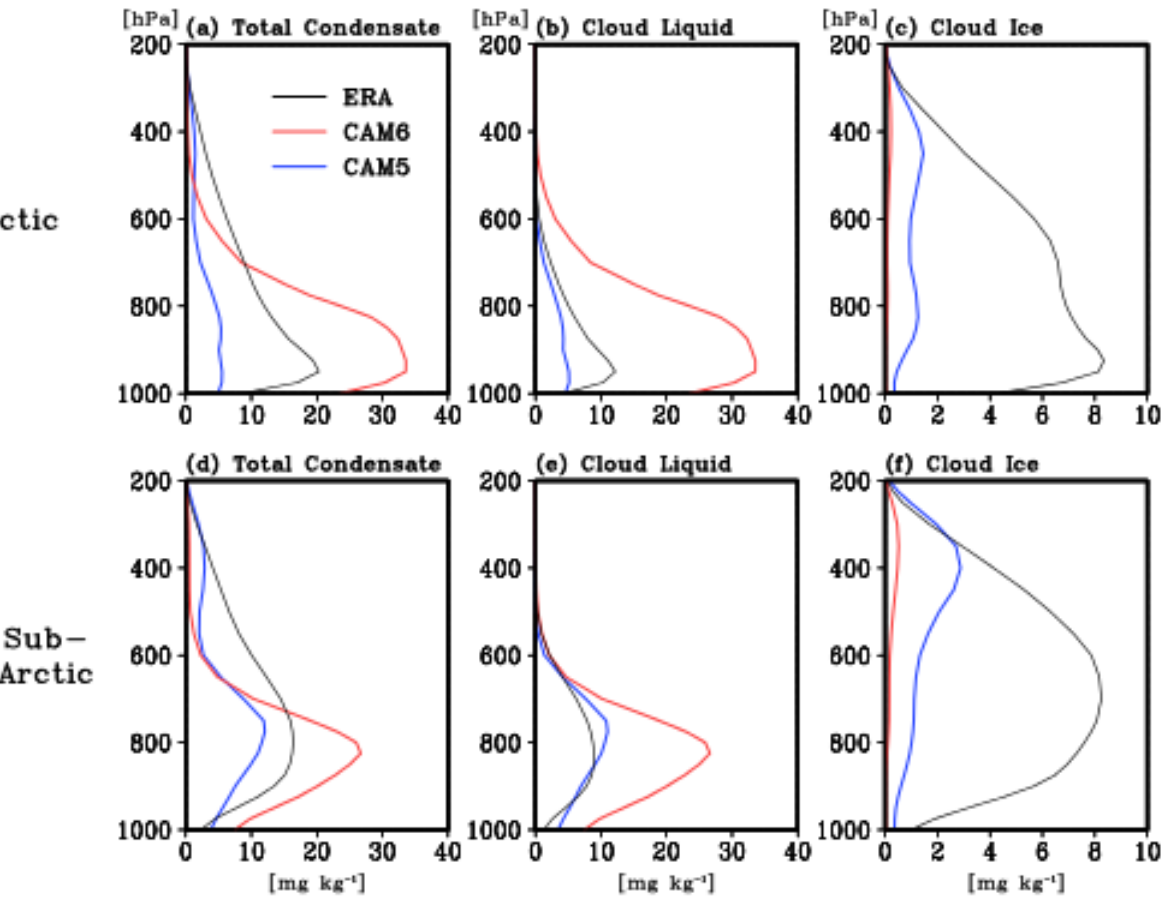
Figure 5. Annual mean vertical profiles of grid-mean ( a ) cloud condensate mass (cloud liquid + cloud ice), ( b ) cloud liquid mass, and ( c ) cloud ice mass averaged over the Arctic from ERA-Interim reanalysis (ERA, black lines), CAM6 (red lines), and CAM5 (blue lines). ( d – f ) are the same as ( a – c ) except for over the sub-Arctic area.